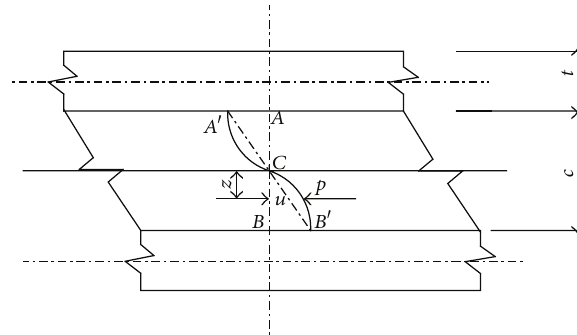
Figure 15: Shear displacement of sandwich